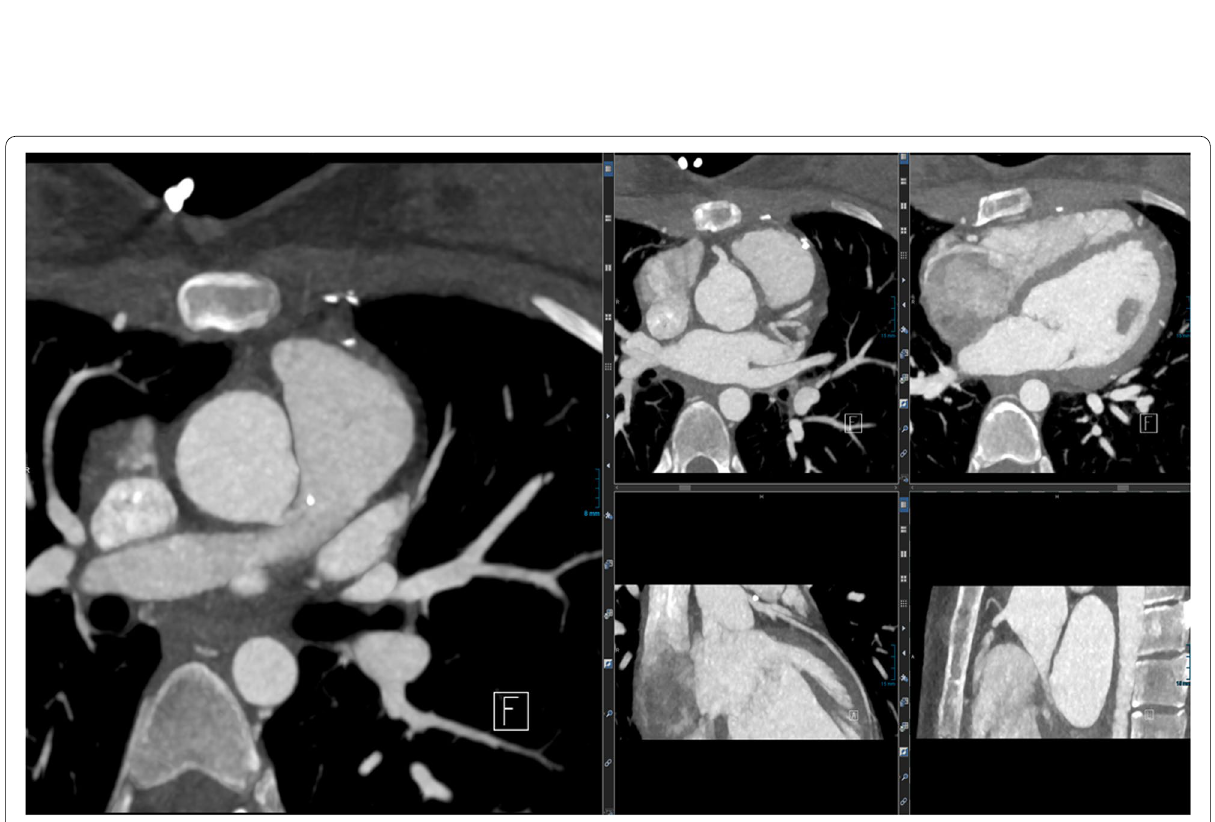
Fig. 3 (Representative images for the primary CT datasets): based on primary axial planes (left), different positions in long-axis heart orientation (right upper row) and parasagittal orientation (right lower row) are depicted. Currently, these standard projections are reconstructed by specifically trained technicians; increasingly AI-based algorithms take over these time-consuming